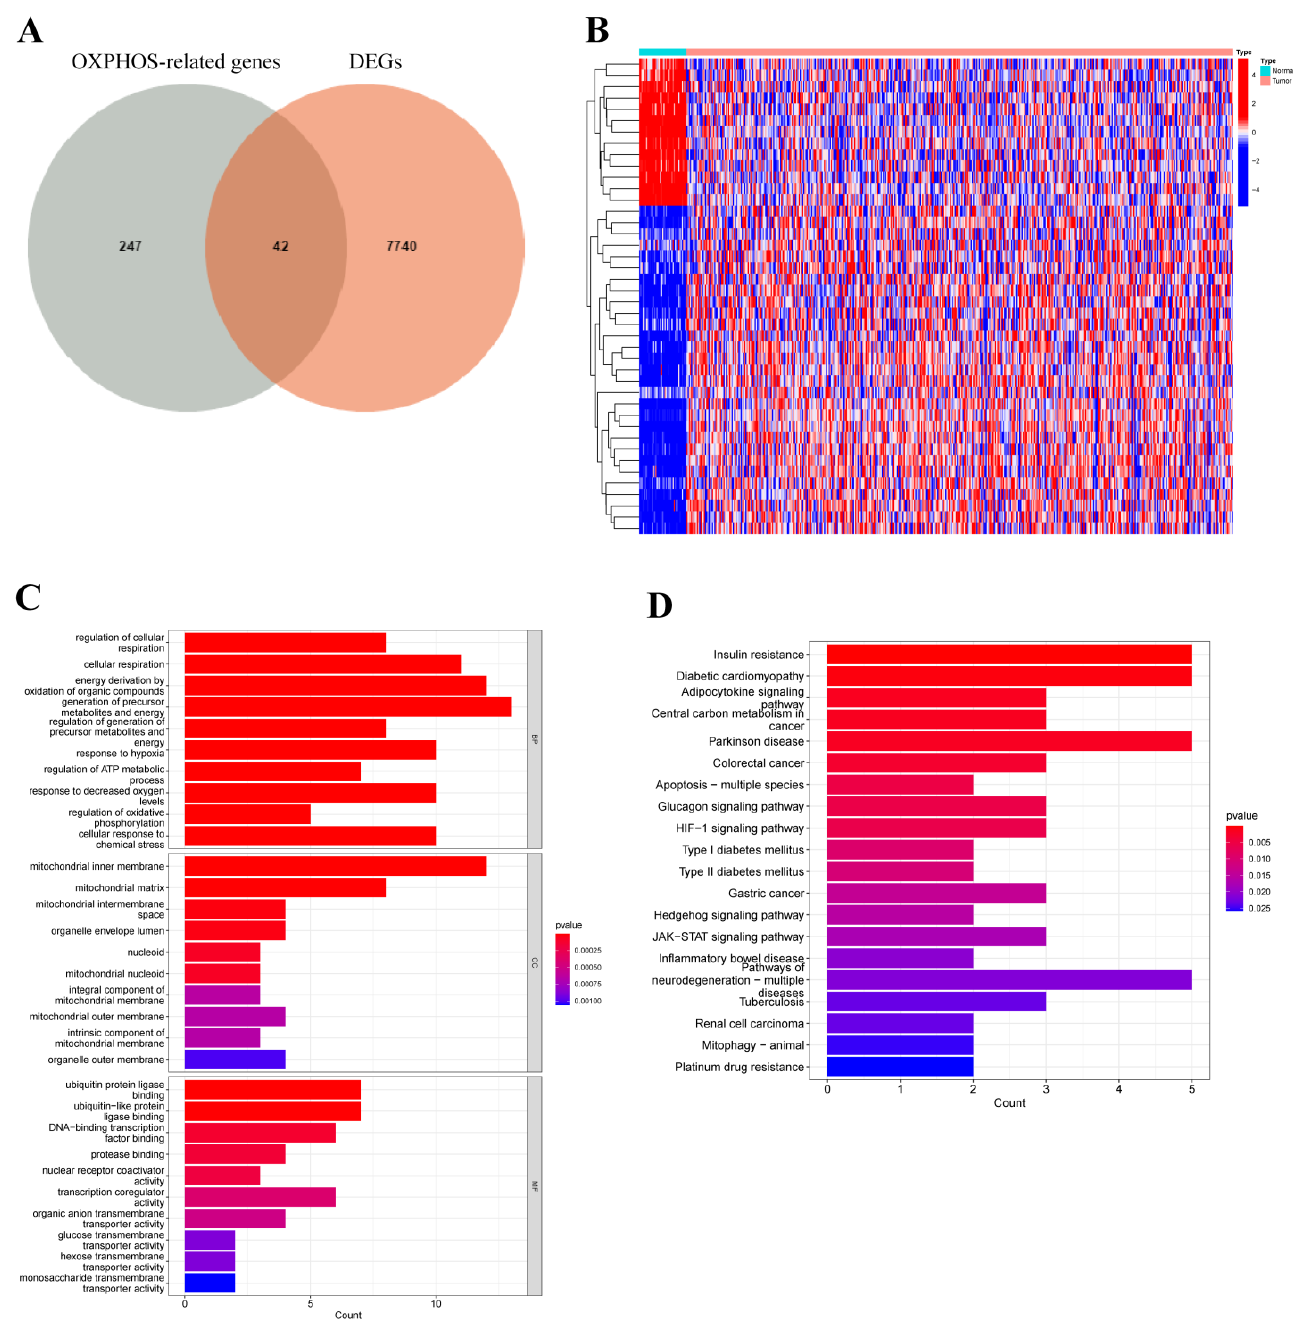
Figure 1. Differential expression analysis and functional annotation of oxidative phosphorylation (OXPHOS)-related gene in patients with COAD. ( A ) Venn diagram revealed the distribution of DEGs and ORGs in COAD. ( B ) The heatmap depicted the different expressions of ORGs between tumor and normal tissues. Blue blocks indicated lower expression and red blocks represented higher expression. ( C , D ) GO terms and KEGG pathway enriched in differentially expressed ORGs.